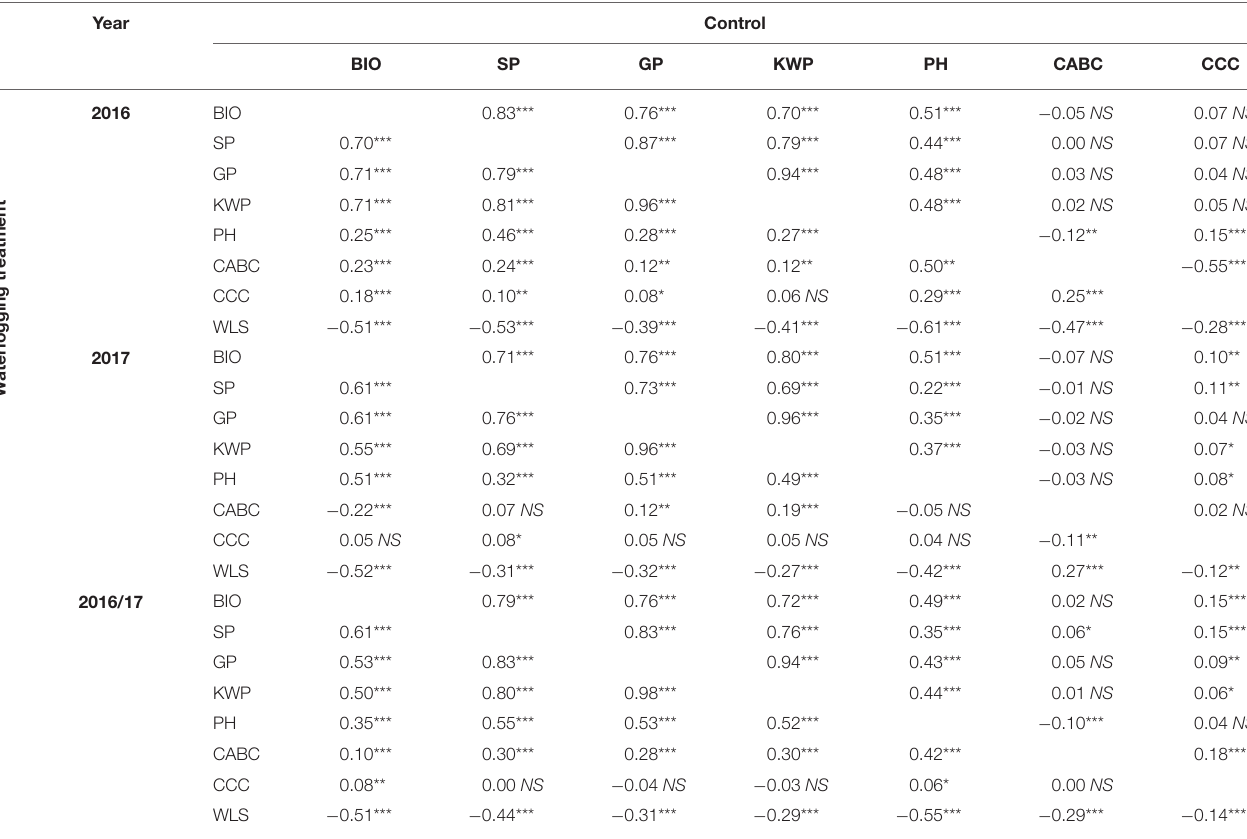
TABLE 2 | Pearson’s phenotypic correlation coefficients among mean variables (least-squares entry means) of traits for control and waterlogging treatment measured in the spring barley collection in field conditions.